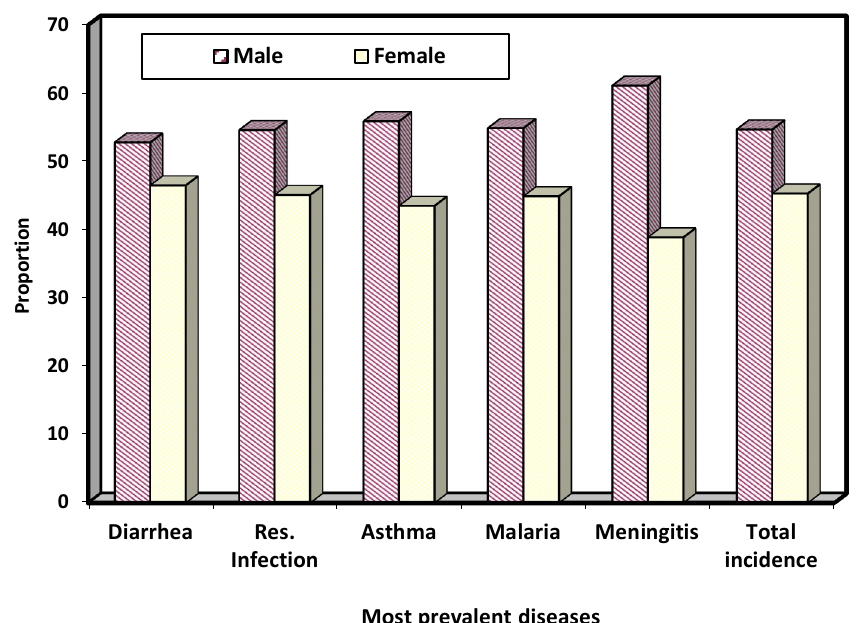
Figure 6. Sex variations in incidence of